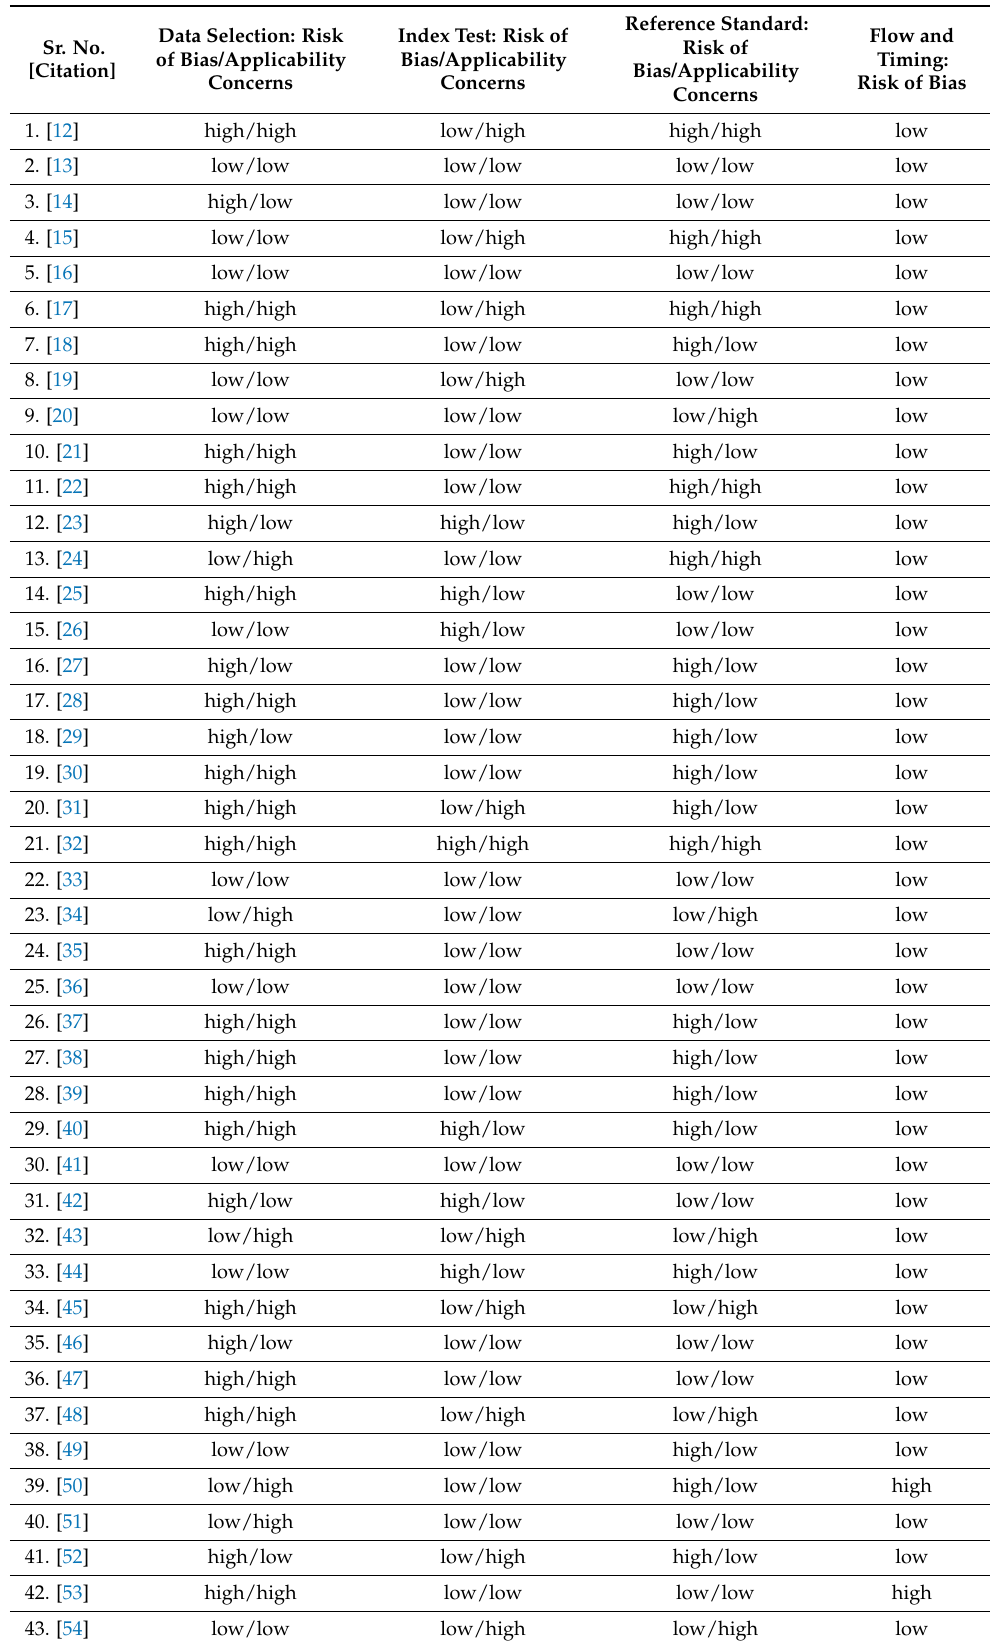
Table 1. Evaluation of risk of bias in studies included ( n = 168) using the QUADAS-2 tool. Sr. No.